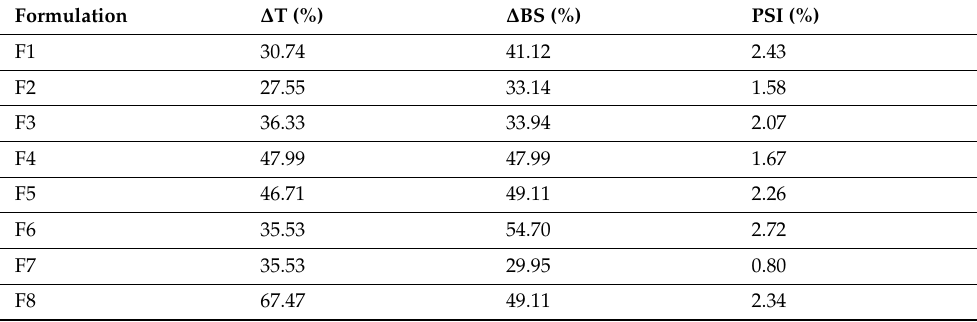
Table 3. Delta transmission, delta backscattering, and PSI of various samples.